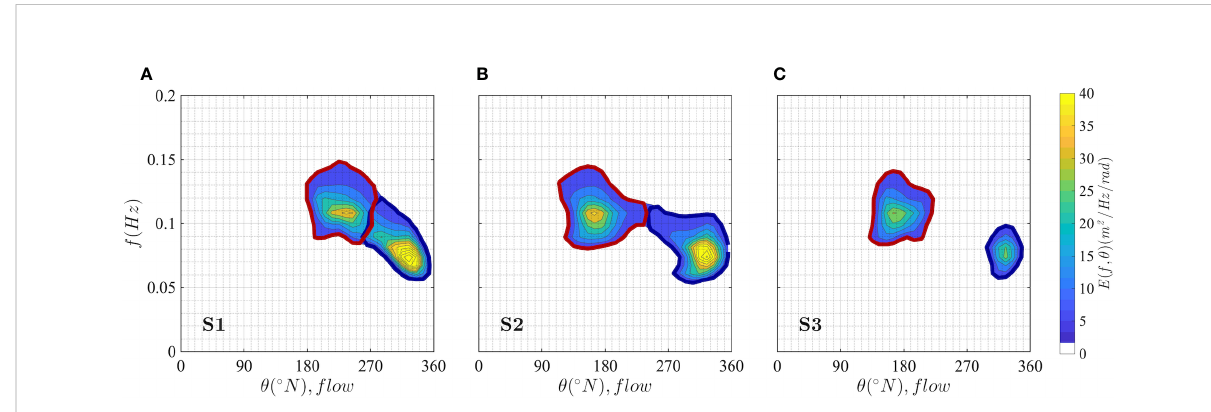
FIGURE 3 Frequency/direction S ( f , q ) wave spectra from ECWAM model at the three selected locations in the Yellow Sea on 5 October 2018 at 04 UTC (S1, A ), on 5 October 2018 at 17 UTC (S2, B ) and on 6 October 2018 at 01 UTC (S3, C ). Wind sea (solid red) and swell (solid blue) partitions are also